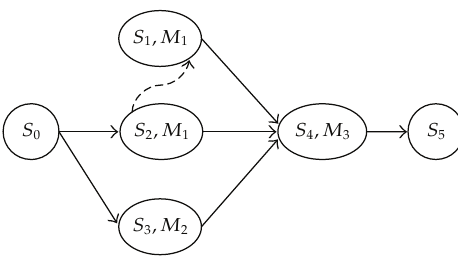
Figure 4: Constructing new precedence.